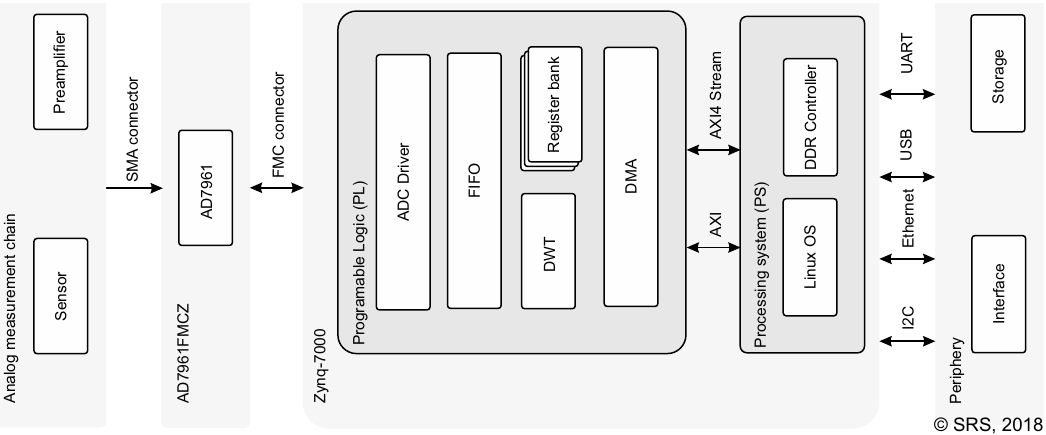
Figure 2. Illustration of the measurement system